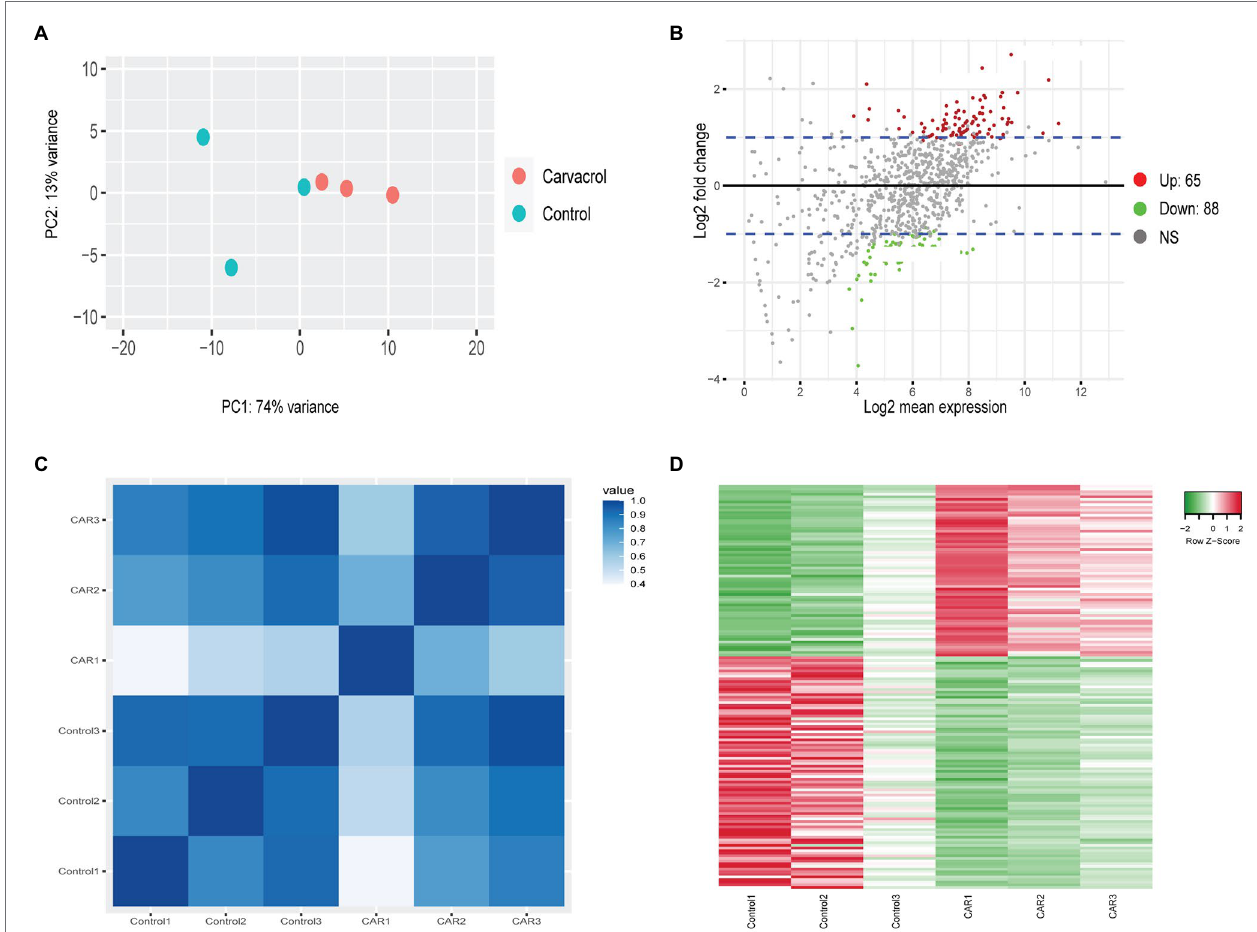
FIGURE 1 | RNAseq analysis of Control vs. carvacrol (CAR) treated Mycoplasma bovis. (A) PCA of the transcriptomes for Control (green) and CAR (orange). Each dot represents a repeat of the experiments. (B) MA-plot (M = log ratio vs. A = mean average) showing upregulated (red), downregulated (green), and unchanged (gray) genes upon treatment of CAR. The plot was generated using an adjusted p -value of 0.1 and a Log 2 fold change of 1. The blue lines denote Log 2 fold change between 1 and − 1. (C) Correlation plot between replicates of Control and CAR-treated samples. The color scale, ranging from white to blue, shows Pearson correlation coefficients ranging from 0.4 to 1, representing high to low correlation. (D) Heat map of Differentially expressed (DGE) gene between Control and CAR- treated samples. The color scale from green to red, corresponding with a z-score from − 2 to 2, shows downregulated to upregulated genes. This clustering was acquired using average linkage and Pearson distance measurement